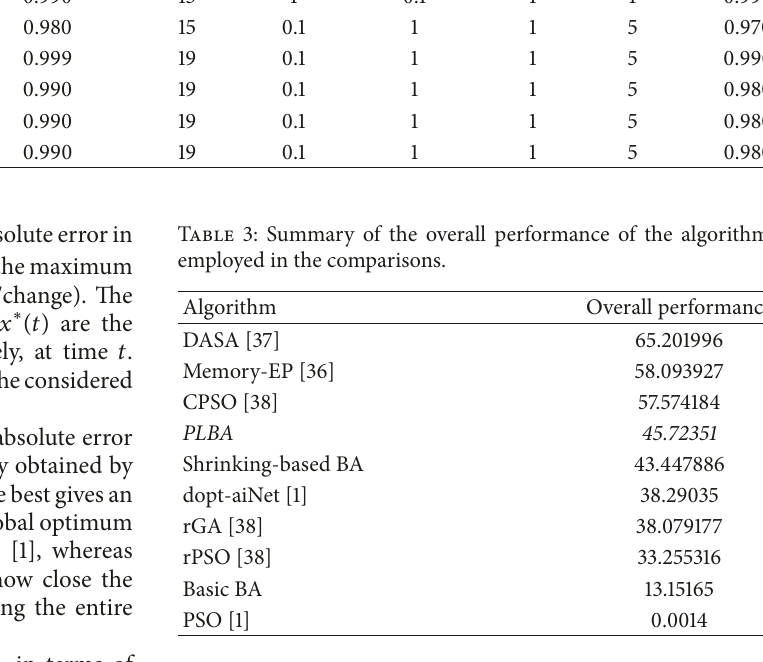
Table 2: The parameters used with different values for different dynamic problems in the BA variants. Basic BA PLBA Function